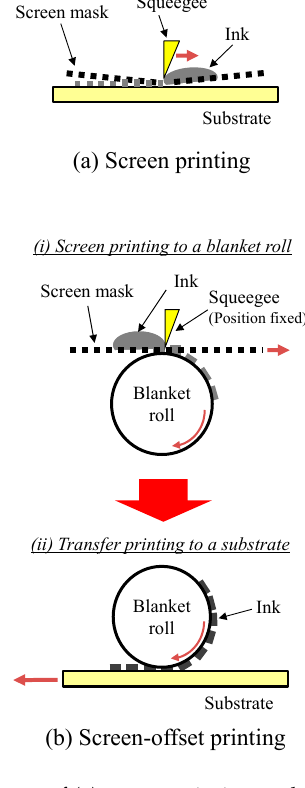
Figure 1. Schematic images of ( a ) screen printing and ( b ) screen-offset printing.